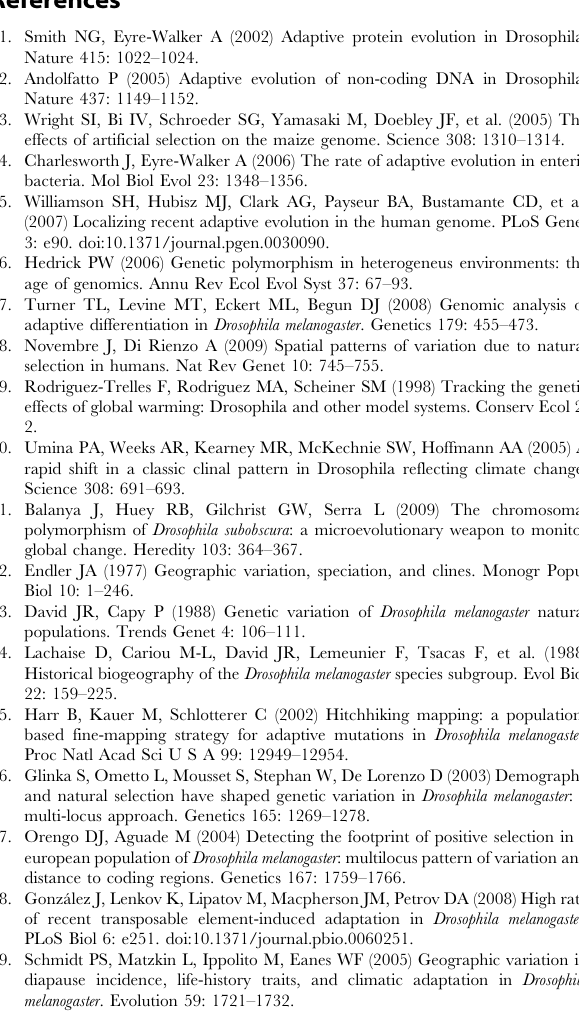
Table S7 Climatic